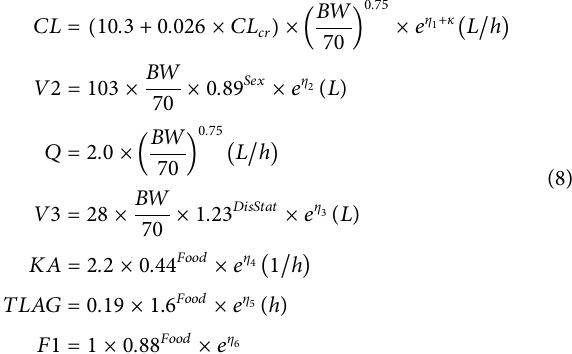
PK data. Correlation between conditional weighted